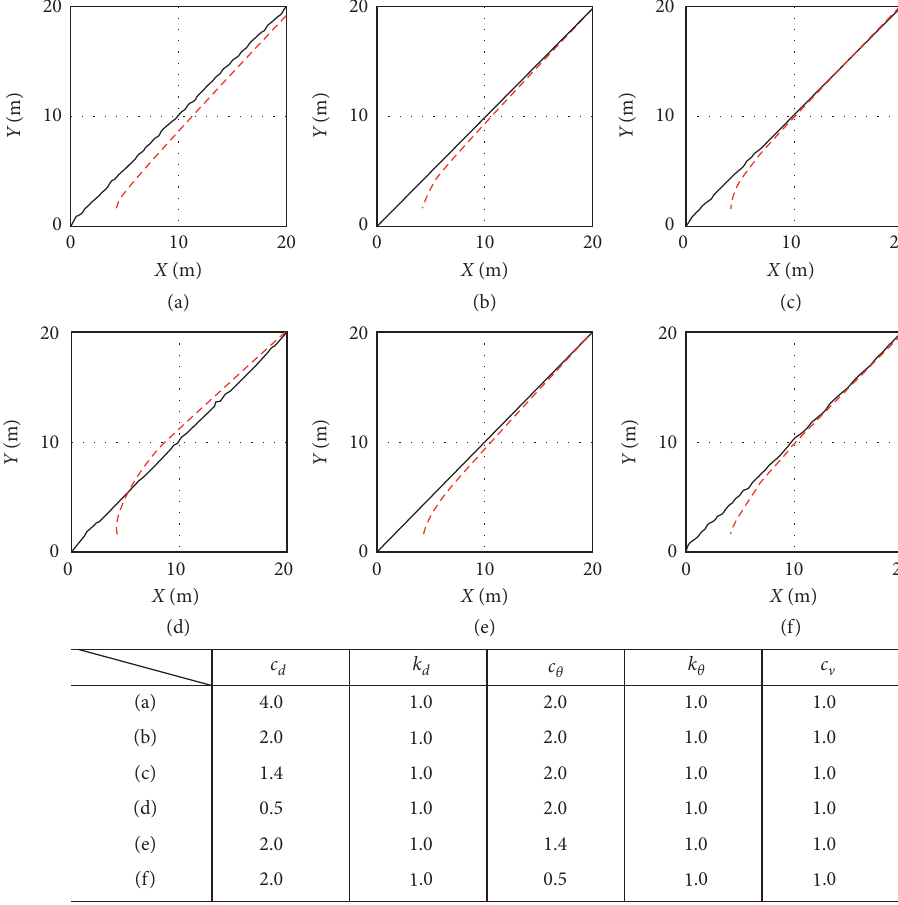
C and Y C govern by equation (12) with a straight reference path and various control parameters